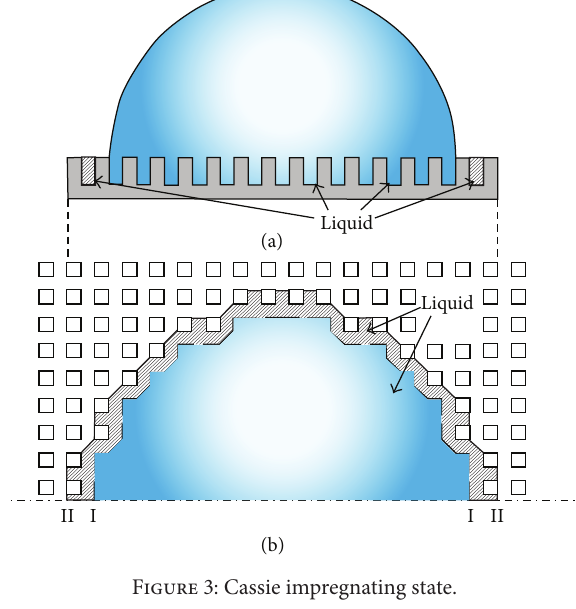
Figure 3: Cassie impregnating state.